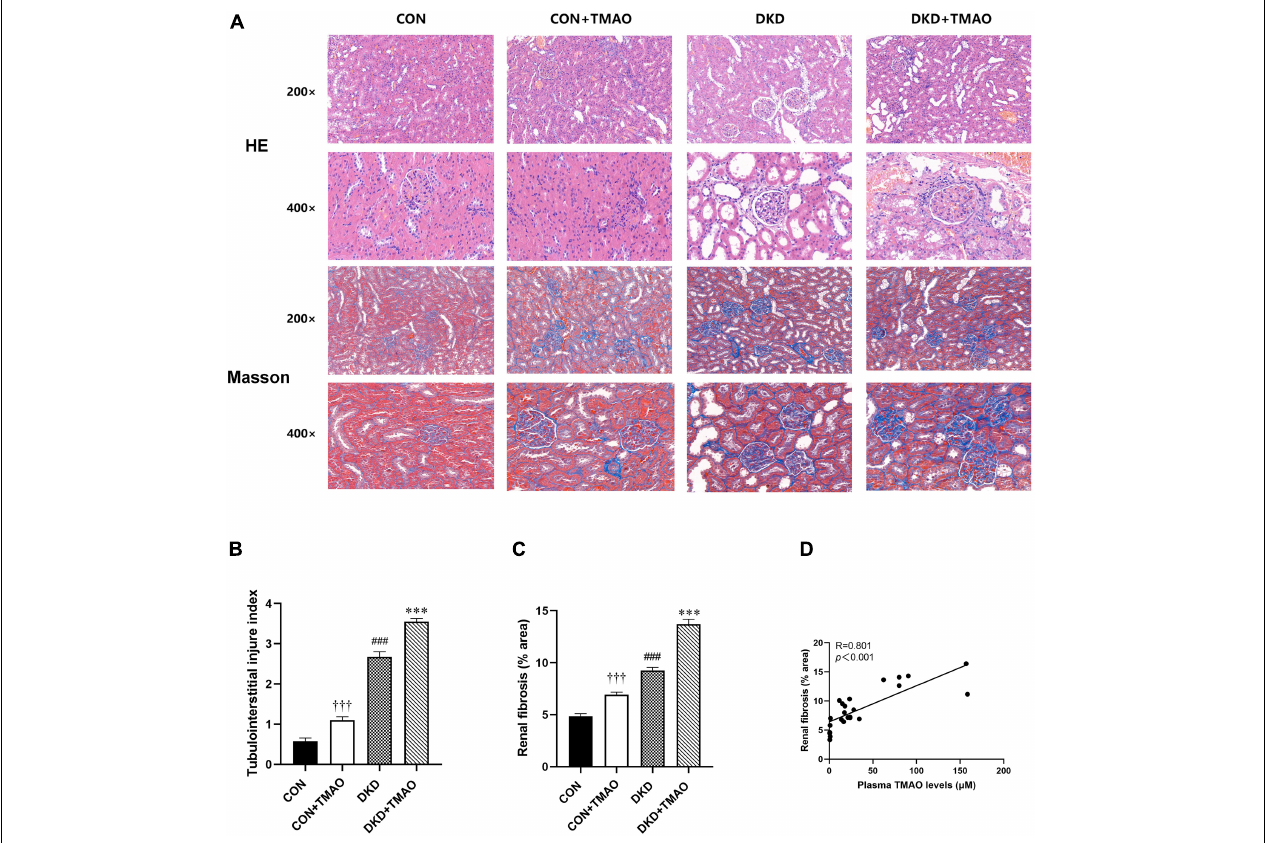
FIGURE 4 | Pathology results in kidney of rats. (A) The results of HE staining and Masson staining in all rat groups (enlargement factor: 200 × , 400 × ). (B) Tubulointerstitial injury index. (C) Fibrosis area of Masson staining. (D) The relationship between plasma TMAO levels and renal fibrosis area. Data are presented as mean ± SEM ( n > 6 for each group). ††† P < 0.001 vs. CON, ### P < 0.001 vs. CON, ∗∗∗ P < 0.001 vs.